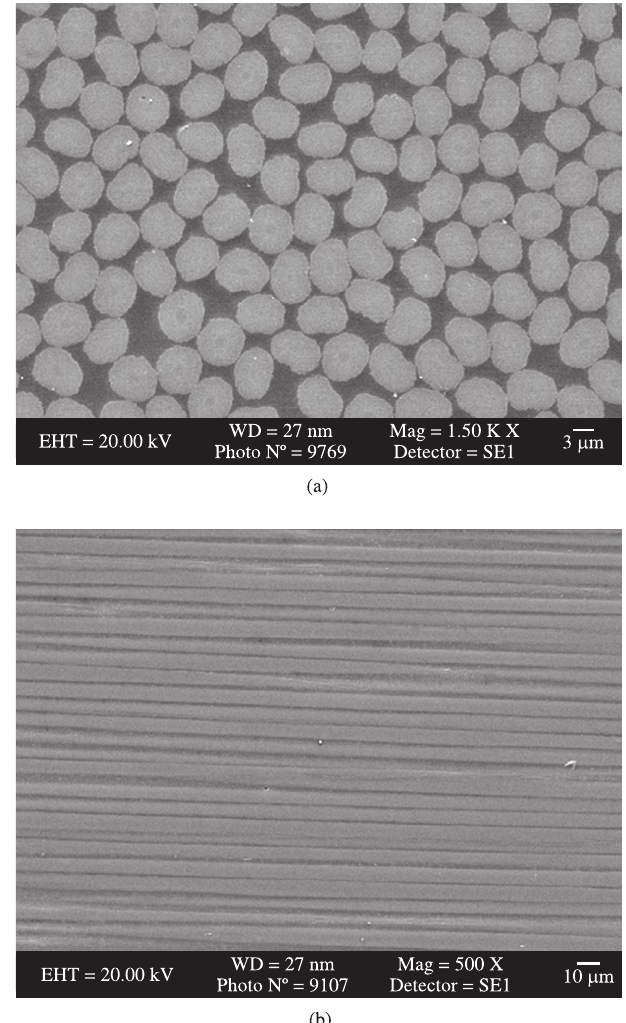
Figure 3. SEM micrograph showing: a) longitudinal and b) cross sectional uniform distribution of carbon fibers in epoxy matrix.